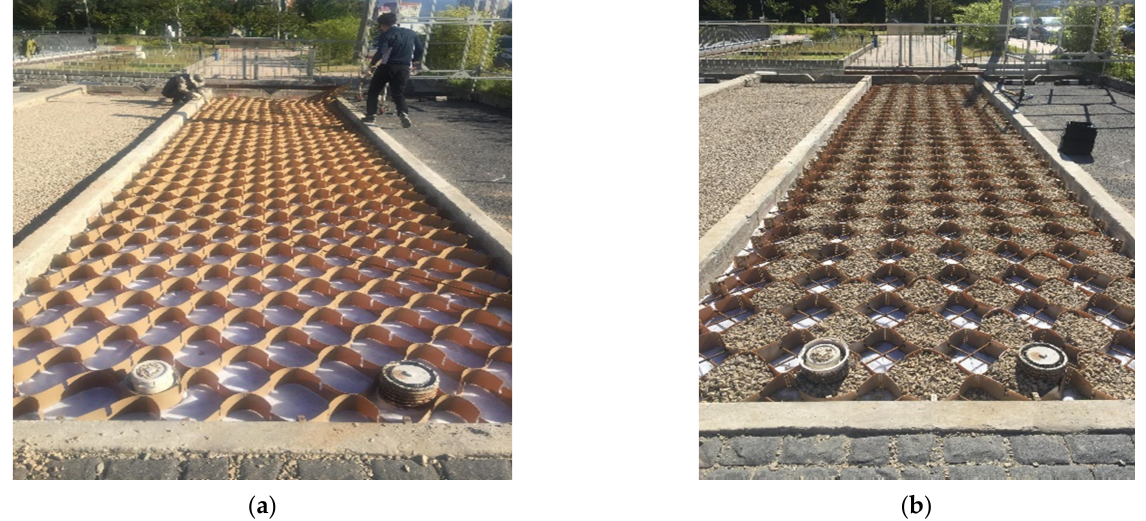
Figure 4. Laying and filling the geocells: ( a ) laying the geocells; ( b ) filling the geocells with aggregate. For the subbase, an aggregate material with a nominal maximum aggregate size of 10 mm and 45 mm was used for the unreinforced and reinforced pavement, respectively. The subgrade of the two pavements comprised a vibration-compacted sand layer, as shown in Figure